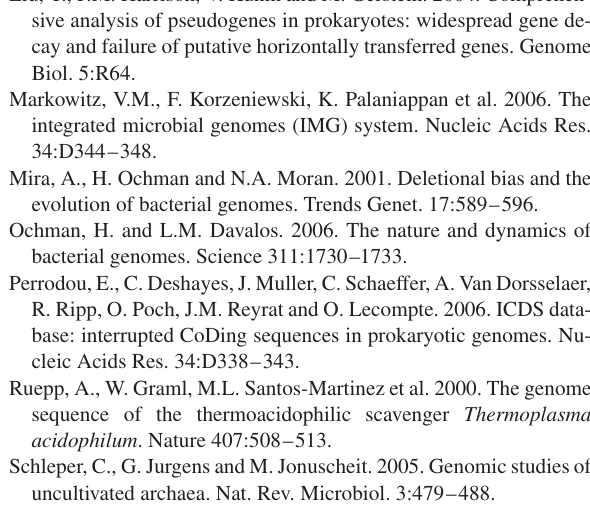
Supplementary Table S2. List of archaeal non-positional pseudogenes. Available at: